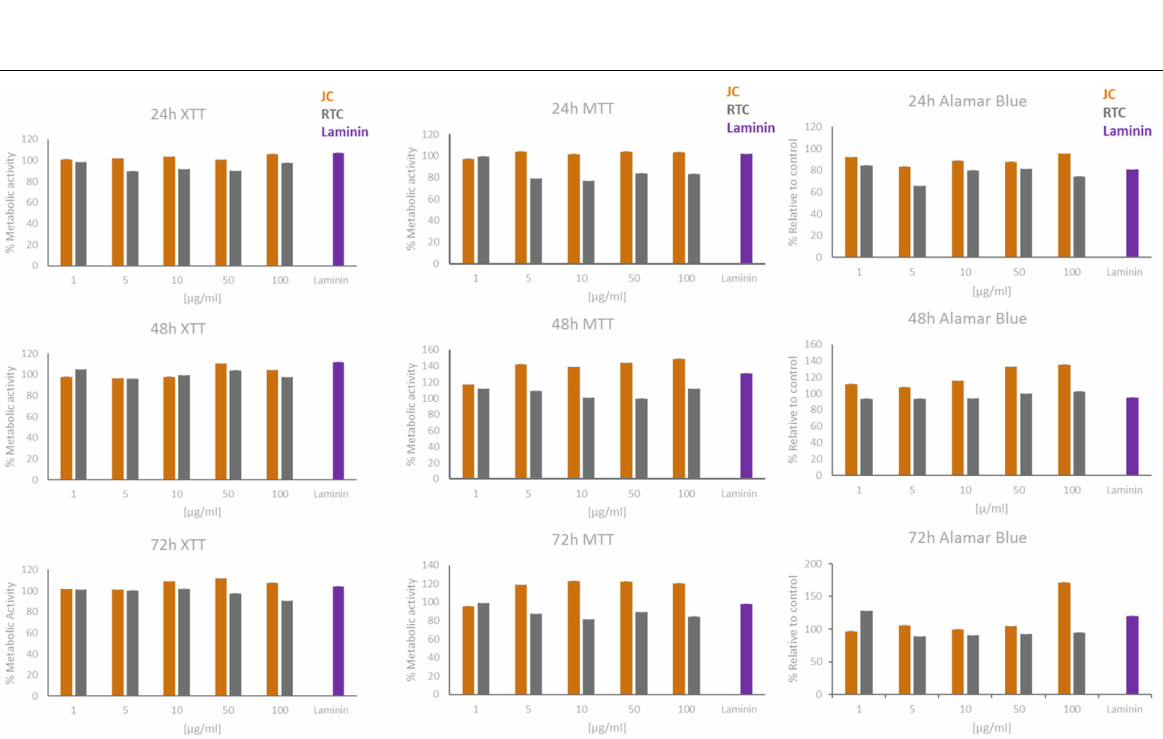
Frontiers in Marine Science |